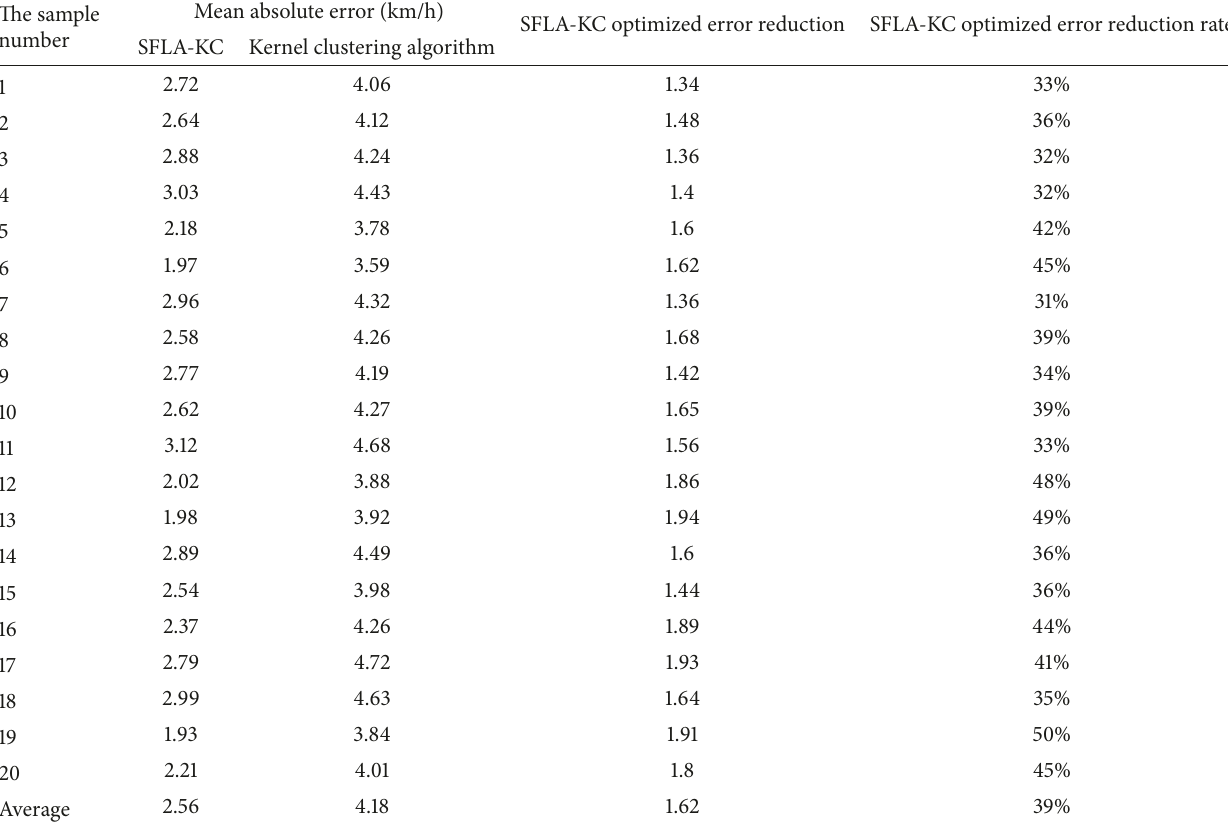
Table 3: Test errors of the SFLA-KC and the kernel clustering algorithm.